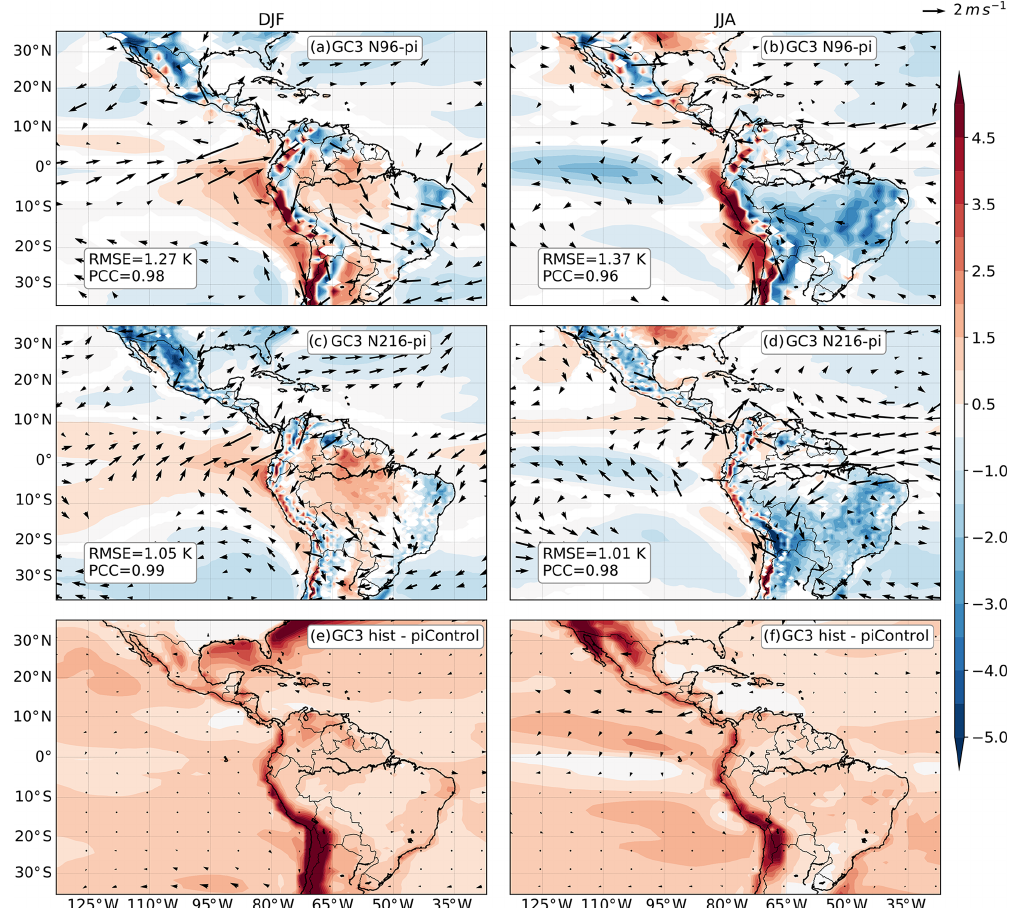
Figure 2. As in Fig. 1, but showing the differences between the piControl simulations of (a, b) GC3 N96-pi and (c, d) GC3 N216-pi and ERA5. Panels (e, f) show the statistically significant differences between the historical (1979–2014) and piControl experiments of GC3. The RMSE and PCC are shown in the bottom left of (a) – (d)